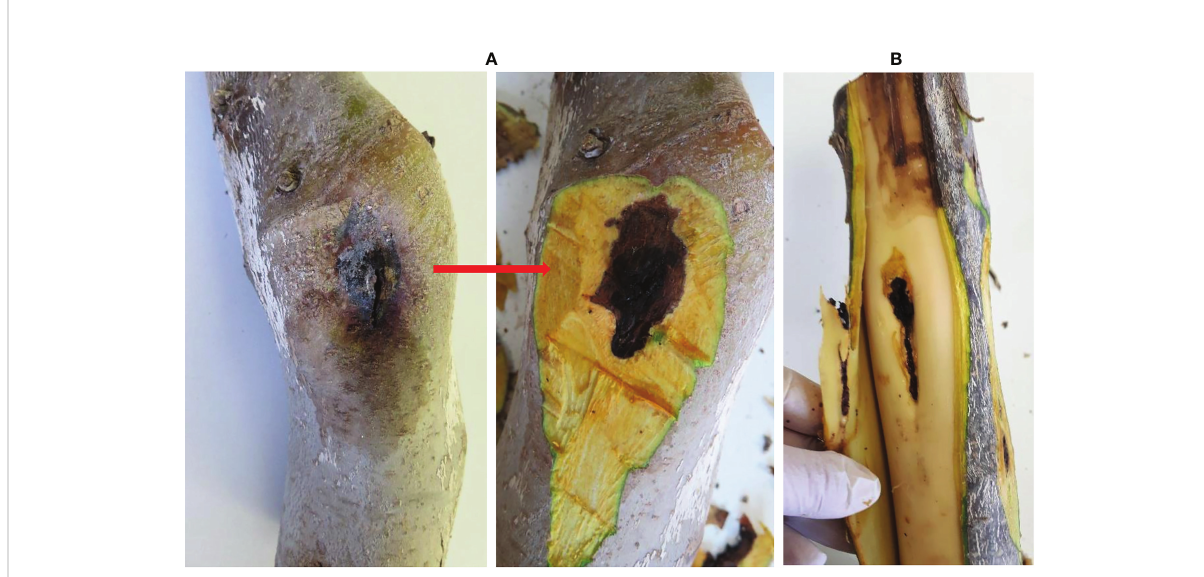
FIGURE 2 Isolation from the symptomatic walnut samples. (A) Dark, roundish, sunken lesions before and after removing the bark; (B) Necrotic lesions under the bark extended into the xylem tissue. Natural